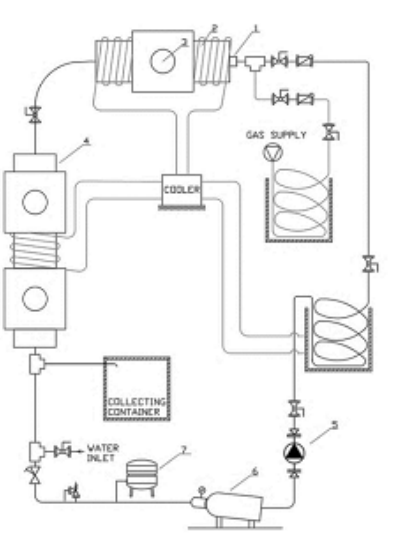
Figure 6. Schematic of experimental equipment